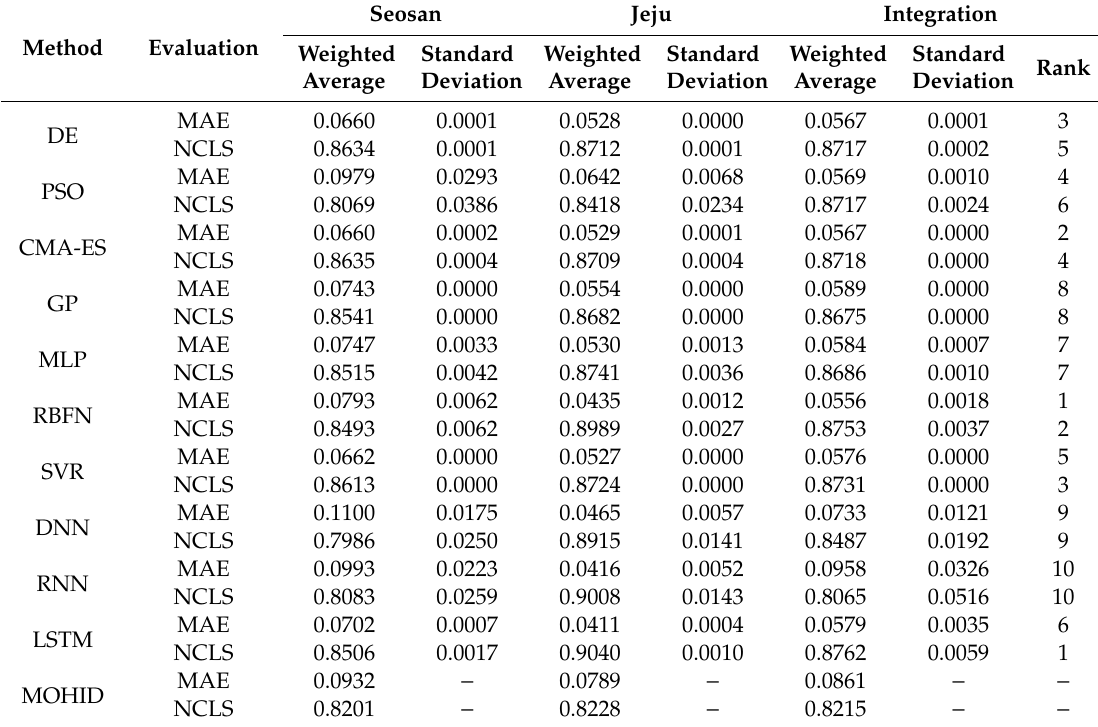
Table 10. Results of weighted average and standard deviation